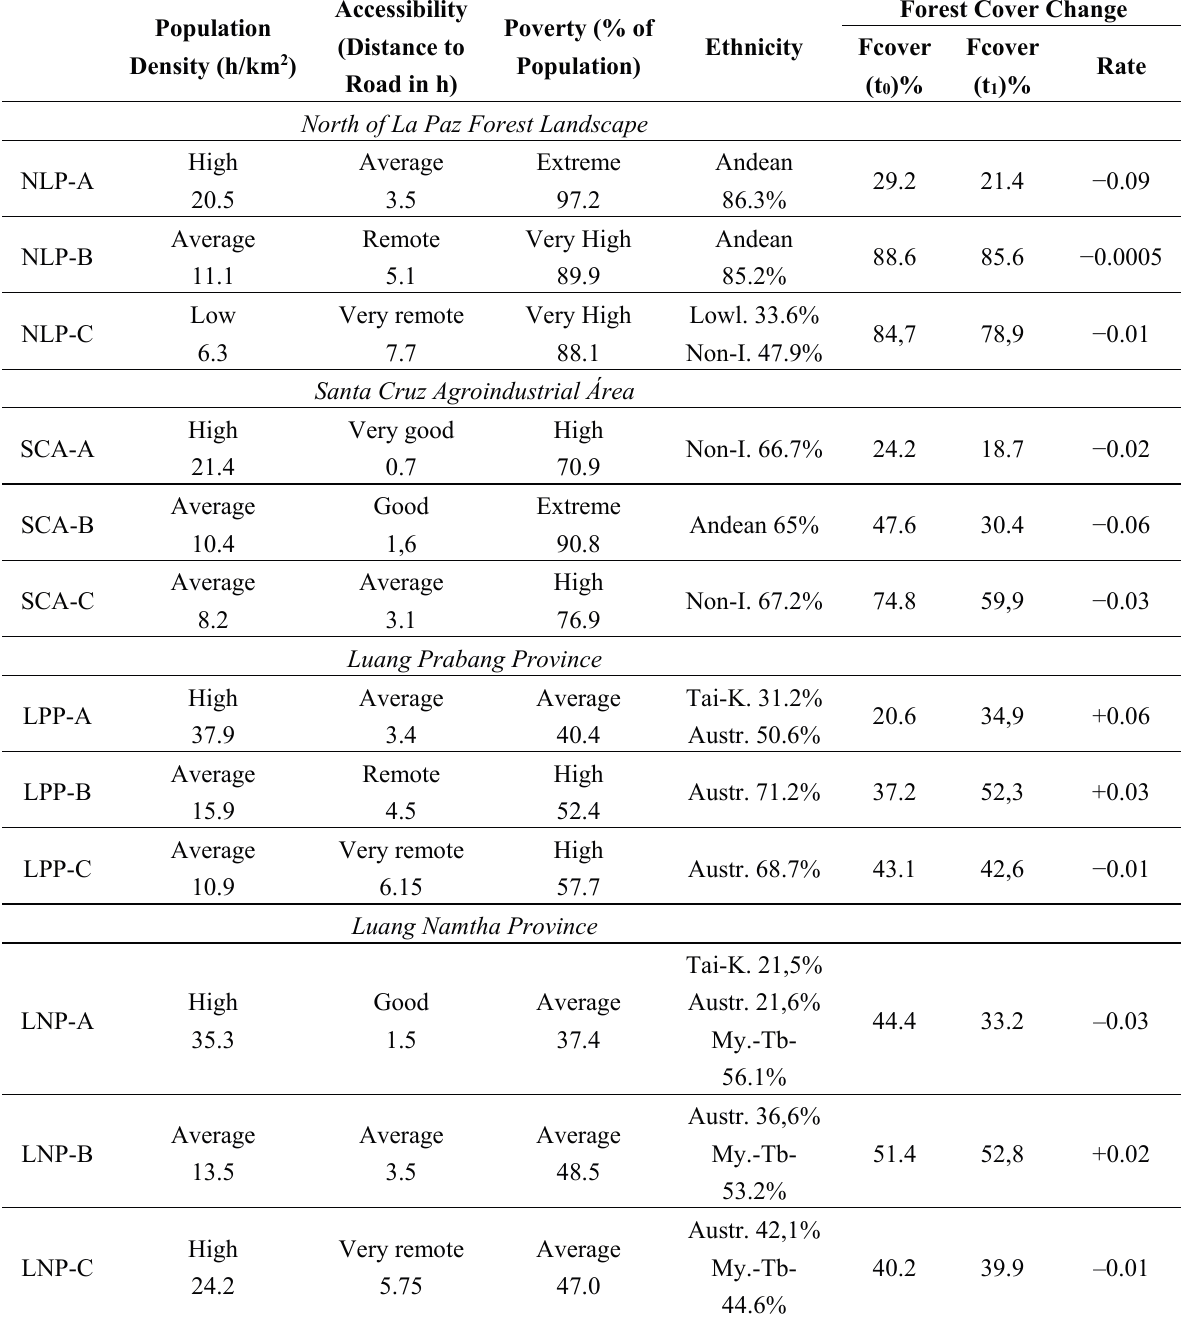
Forest Cover Change Ethnicity Fcover Fcover Rate (t 0 )% (t 1 )%